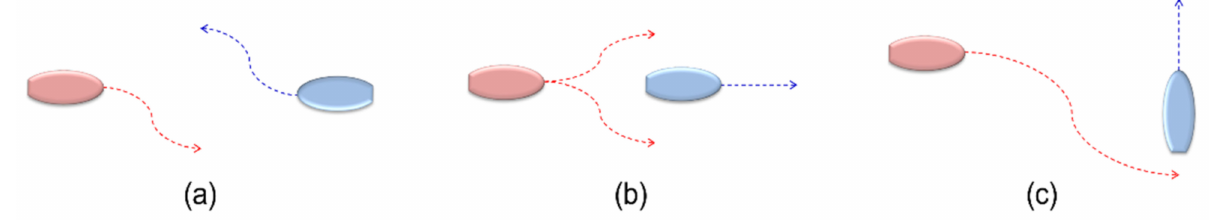
Figure 1. Routes of steering for collision avoidance in